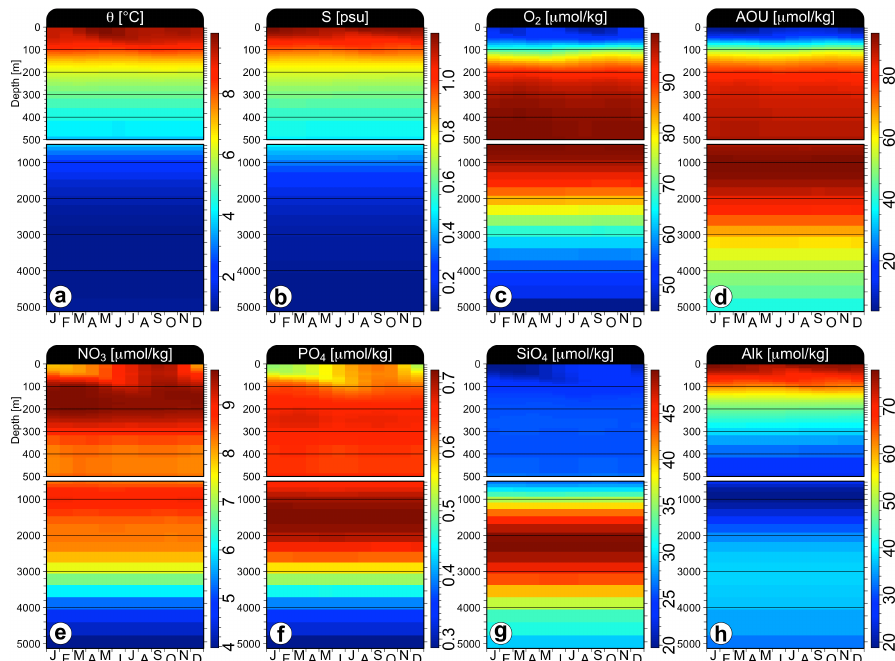
Fig. A1. Monthly vertical profiles of the horizontal spatial standard deviation, from January to December, expressed in (a) ◦ C, (b) psu or (c–h) µmolkg − 1 , for the hydrographic variables used in this study for the year 1995 as sampled on the GLODAP grid. Tick marks to the right of the main panels show the vertical position of the vertical layers in the circulation model.